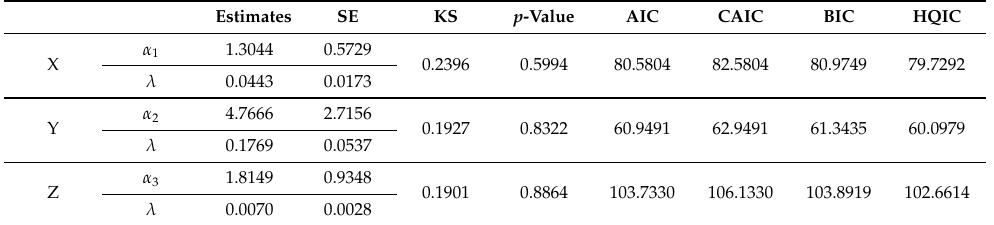
MSE3.1MSE4.1MSE1.1MSE8.4MSE8.3MSE8.2MSE4.2MSE4.3MSE4.4MSE2.4MSE2.3MSE2.2MSE6.2MSE6.4MSE6.3MSE1.4MSE1.3MSE1.2MSE3.4MSE3.3MSE3.2MSE7.4MSE7.2MSE7.3MSE5.4MSE5.2MSE5.3MSE8.1MSE6.1MSE7.1MSE5.1MSE2.1 MSE4.4MSE4.3MSE4.2MSE8.4MSE8.2MSE8.3MSE2.4MSE2.2MSE2.3MSE6.4MSE6.3MSE6.2MSE7.4MSE7.3MSE7.2MSE3.4MSE3.2MSE3.3MSE1.4MSE1.3MSE1.2MSE5.4MSE5.3MSE5.2MSE8.1MSE6.1MSE1.1MSE2.1MSE5.1MSE7.1MSE4.1MSE3.1 Figure 3. Heatmaps of MSE for parameters and R based on different estimation methods: Case III and IV. Table 6. ML and Bayesian estimates for reliability in stress–strength model based on complete